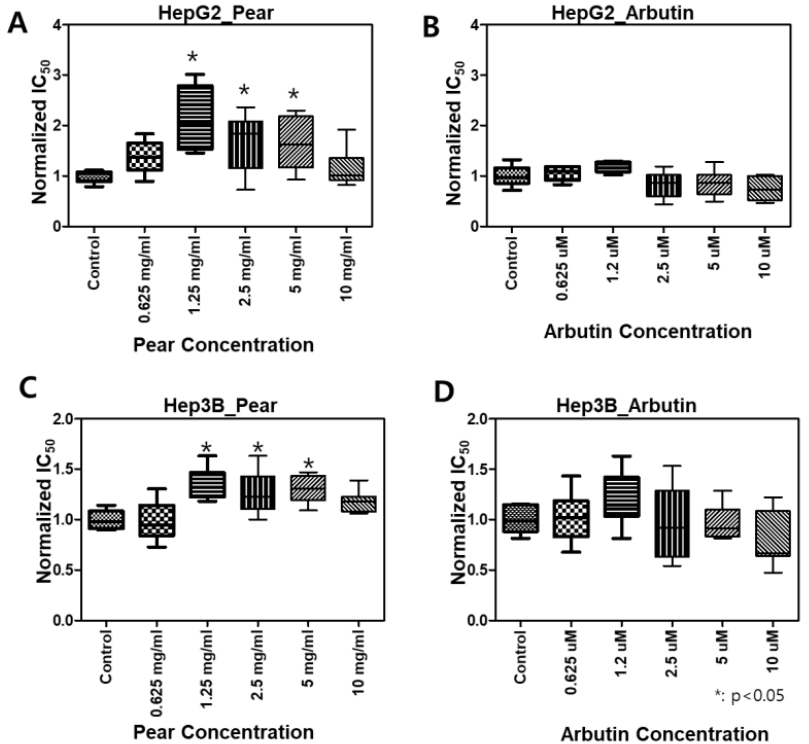
Figure 4. Korean pears reduced BPA cytotoxicity in both Hep3B cells and HepG2 cells under the micropillar/microwell platform.